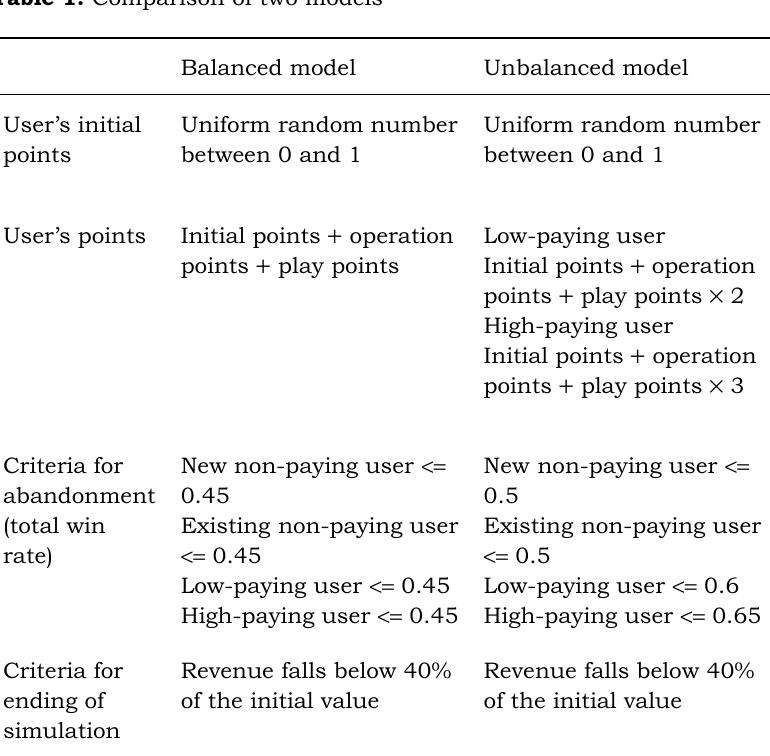
Table 1. Comparison of two models Balanced model Unbalanced